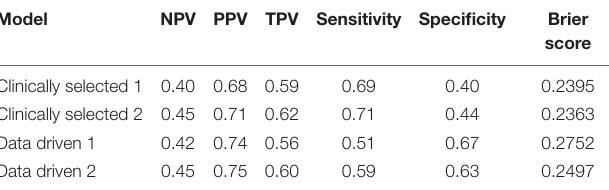
TABLE 6 | Predictive accuracy of